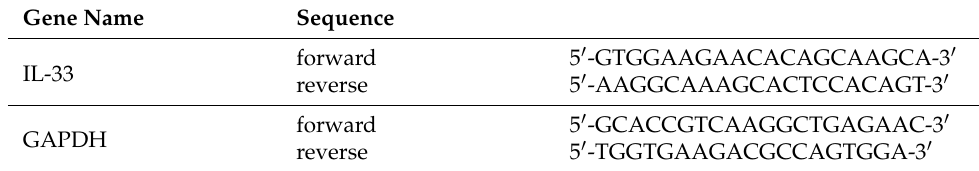
Table 2. List of primers used in the real-time RT-PCR analysis.